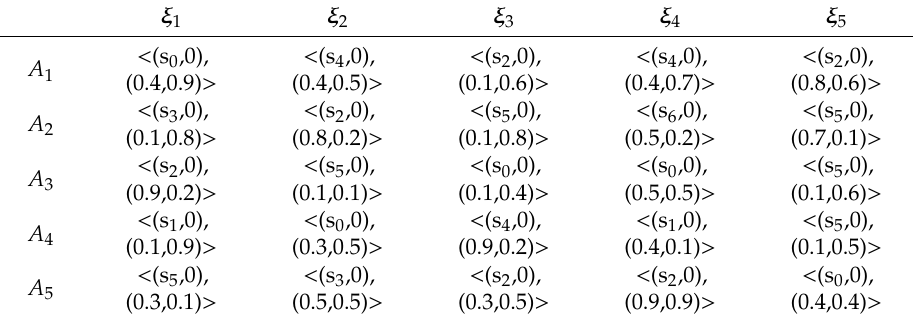
Table 5. P2TLN decision matrix by DM